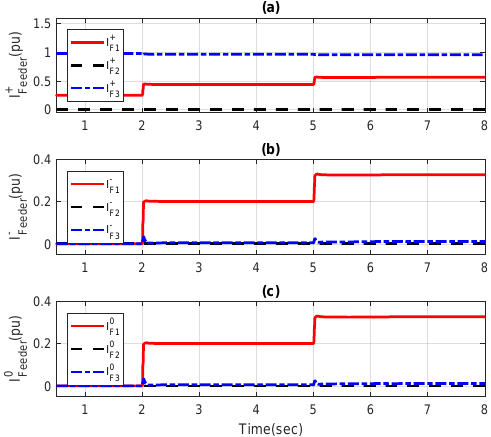
Figure 10. ( a ) Positive-, ( b ) negative- and ( c ) zero-sequence currents of the feeders.